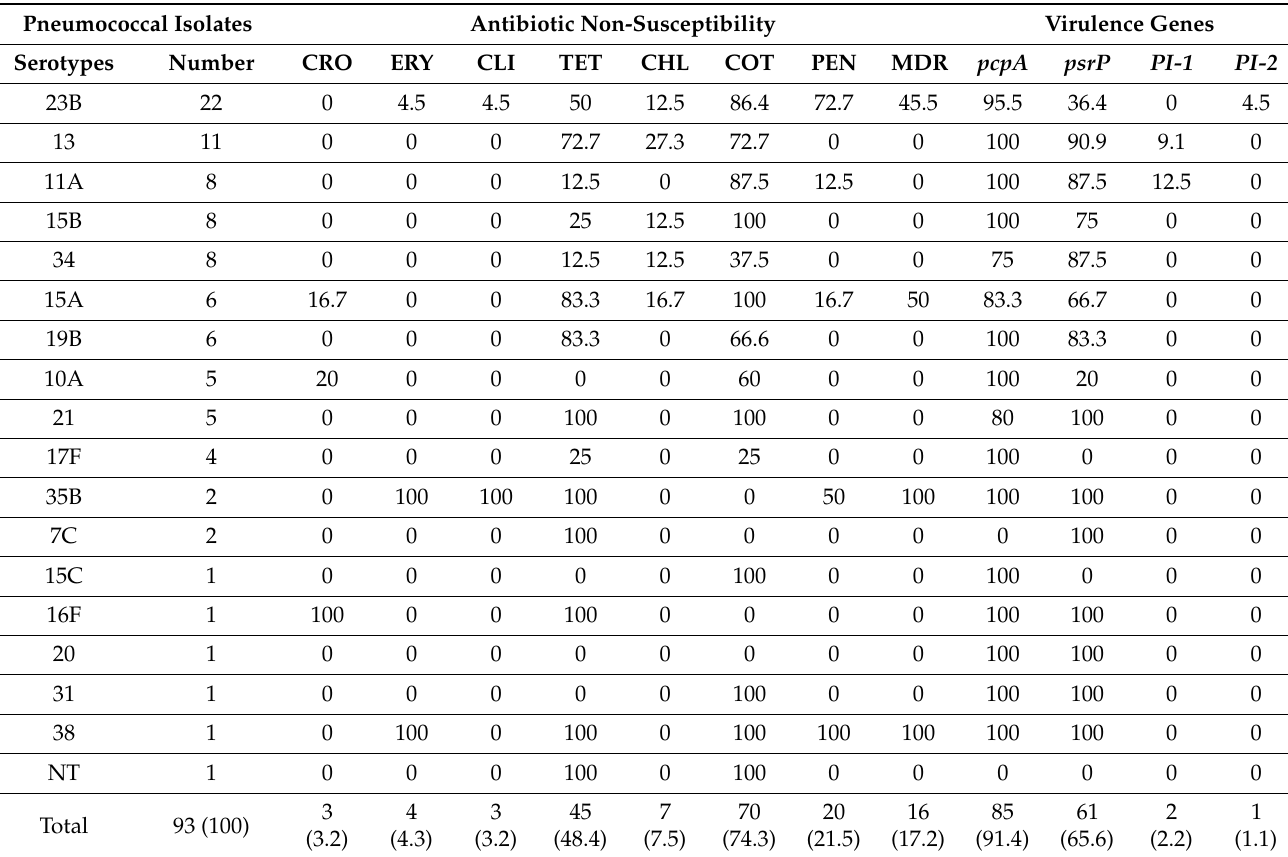
Table 1. Distribution of virulence genes and antibiotic non-susceptibility patterns of non-PCV13 serotypes in Cape Coast,